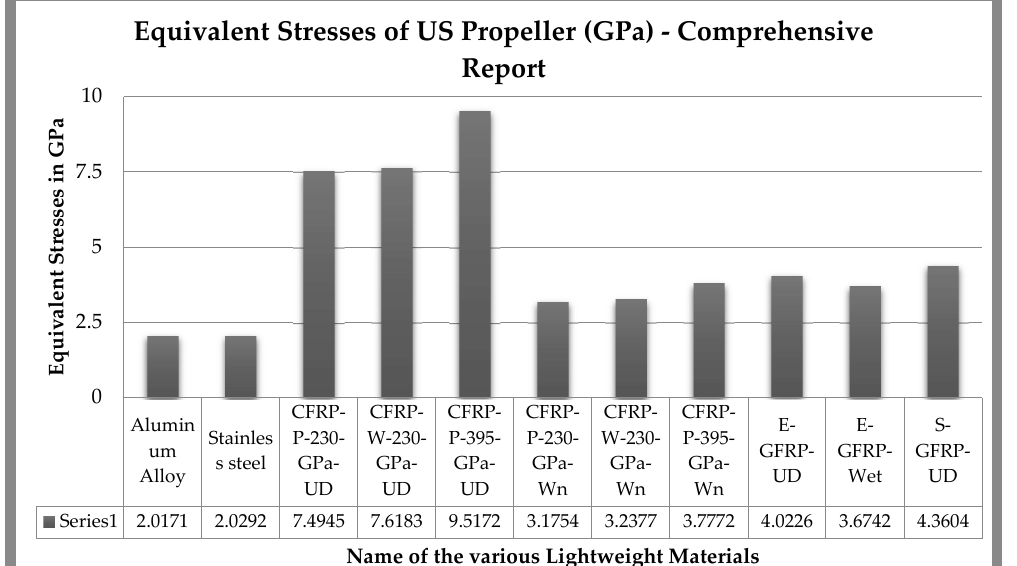
Figure 25. Comparative structural parameters 300 m with the speed of 20 m/s—Deflections.